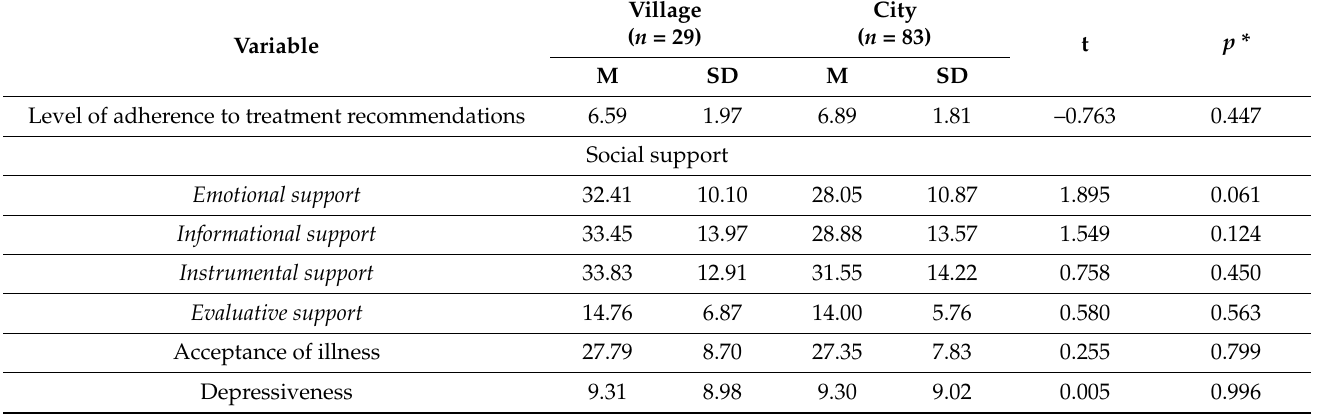
Table 4. Adherence to treatment, social support according to the ISSB, acceptance of disease according to the AIS, and depression according to the BDI among liver transplant patients by place of residence.